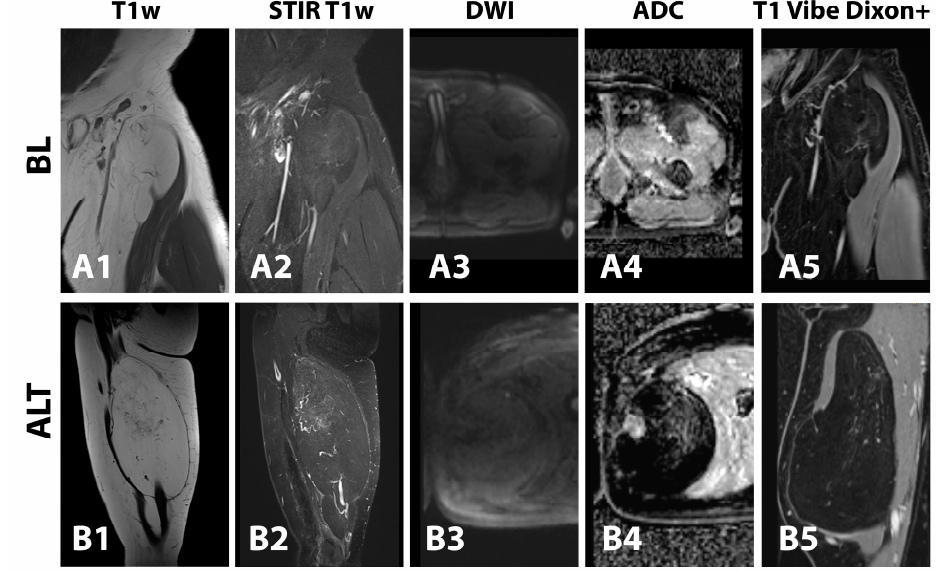
Figure 8. Examples of a benign (BL, ( upper row )) and an atypical lipomatous tumor (ALT, ( lower row )) in T1-weighted ( 1st column ), short-tau inversion recovery T1-weighted ( 2nd column ), diffusion-weighted ( 3rd column ) images, ADC maps ( 4th column ) and T1 VIBE Dixon images after intravenous contrast administration ( 5th column ). Both tumors are predominantly composed of fat, yet the larger ALT shows intratumoral areas of patchy T1w signal decrease, STIR signal increase, atypical septation and patchy contrast